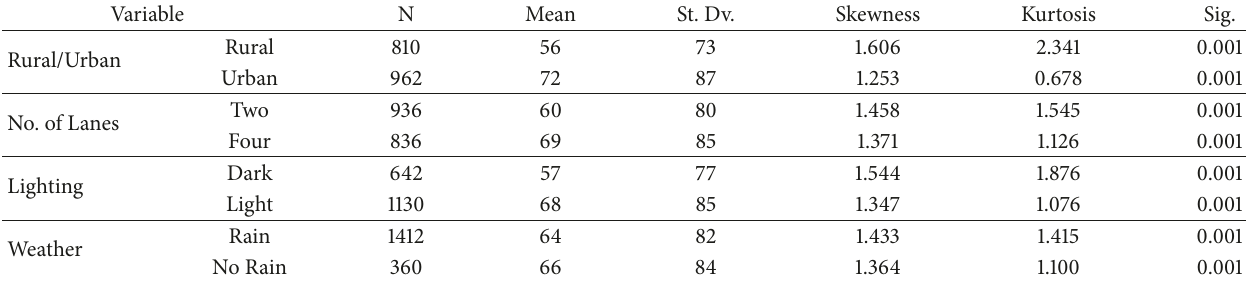
Table 5: Descriptive statistics of the nonsevere wet-weather crash rates across the categorical variables and tests of normality for the selected ten routes.